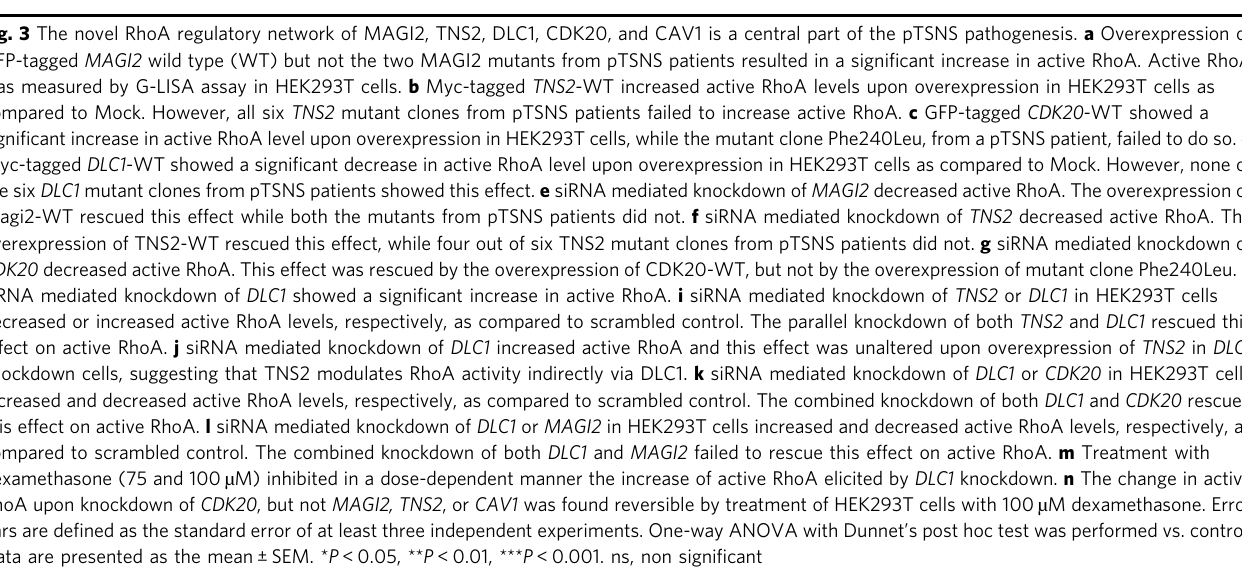
Data are presented as the mean ± SEM. * P < 0.05, ** P < 0.01, *** P < 0.001. ns, non signi fi